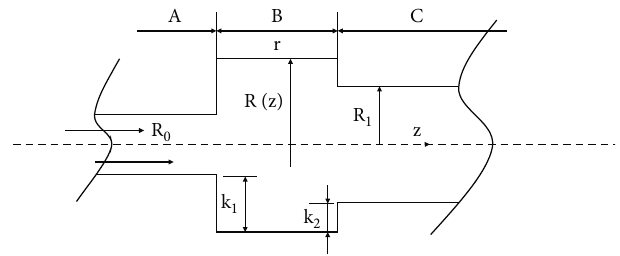
Figure 3: Schematic diagram of the variable section